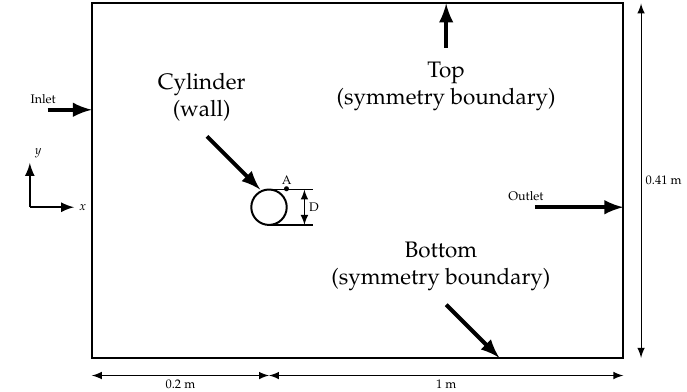
Figure A1. Sketch of the geometry and the boundary conditions used for the computational domain.